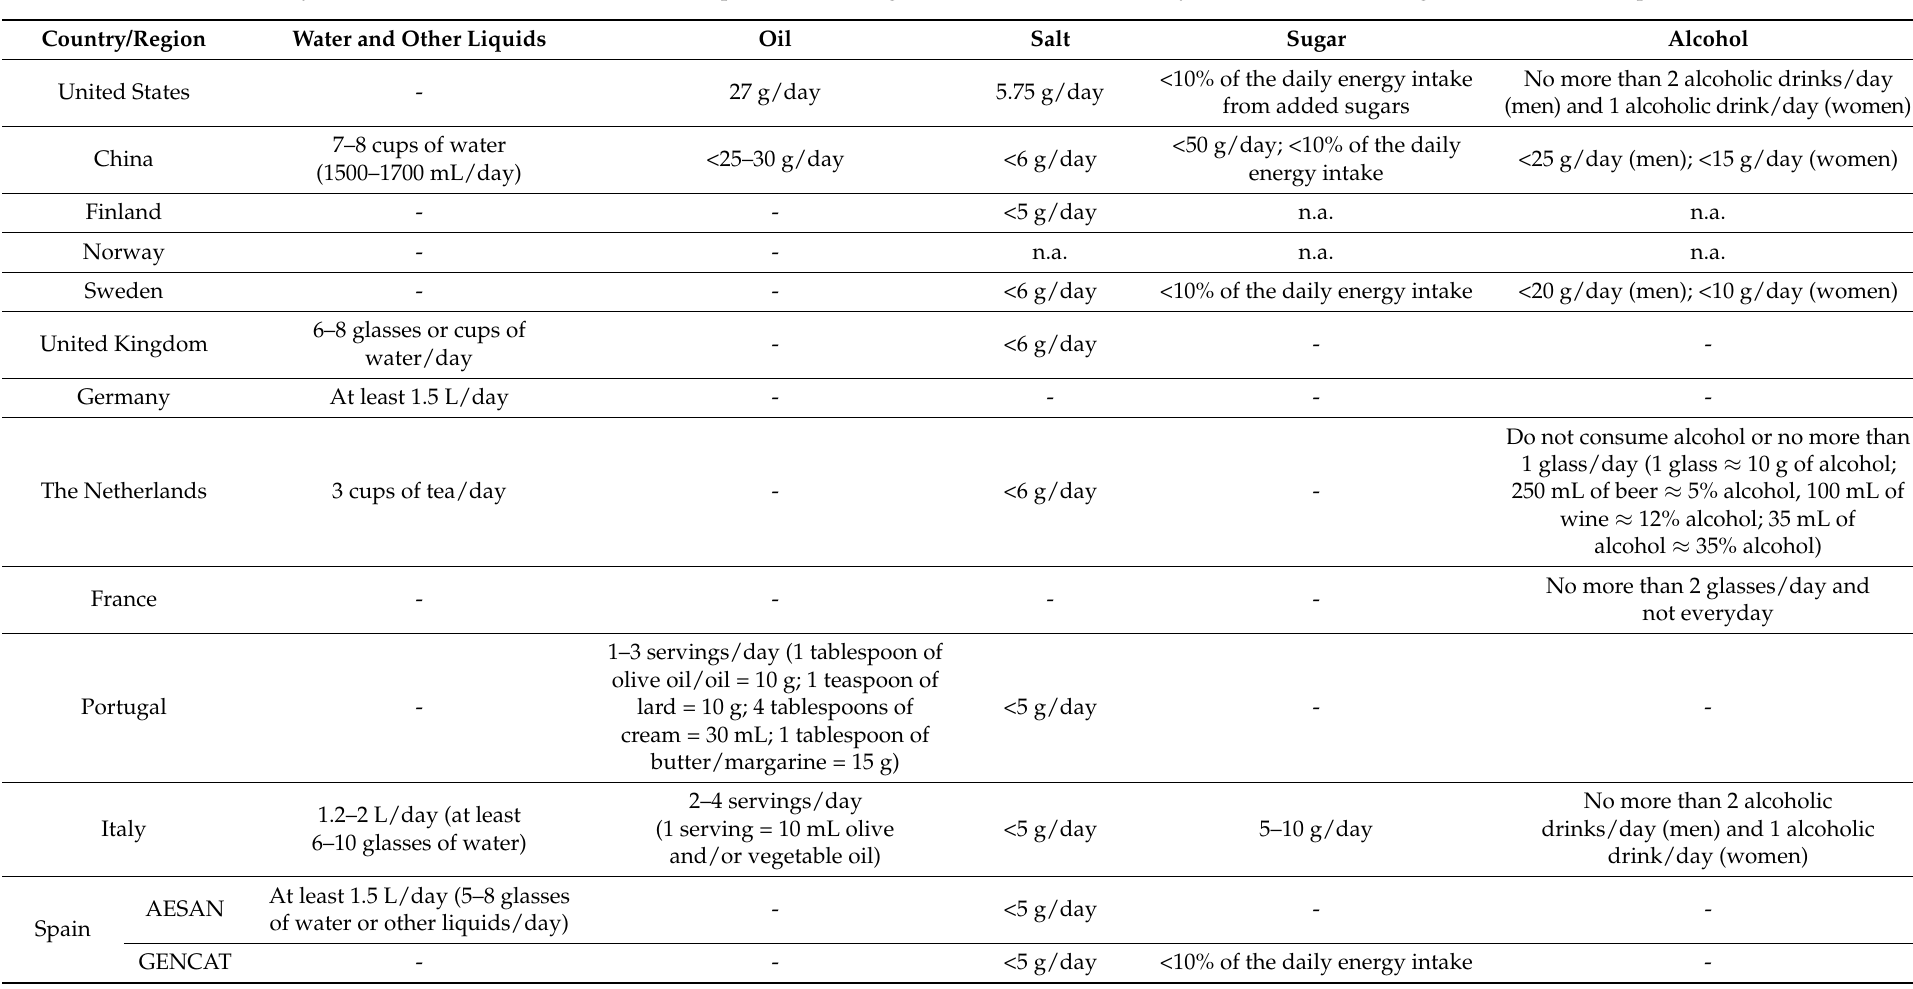
Table 6. Dietary recommendations for water and other liquids, oil, salt, sugar, and alcohol established by the international food guides selected in the present work.